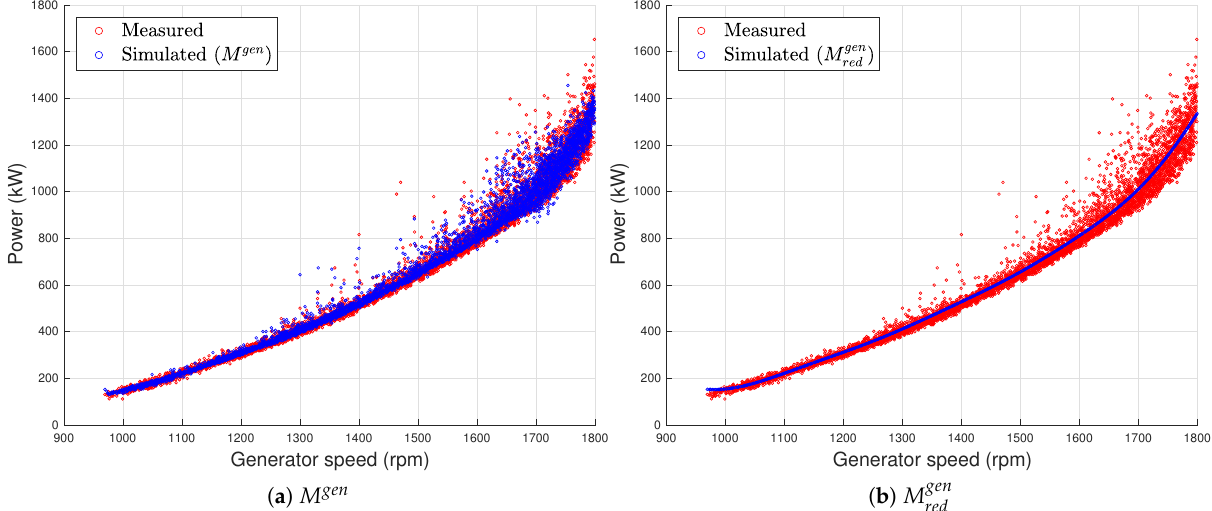
Figure 6. Measured and simulated generator speed-power curves: D2 data set, T1 wind turbine. M gen model on the left, M gen on the right. red